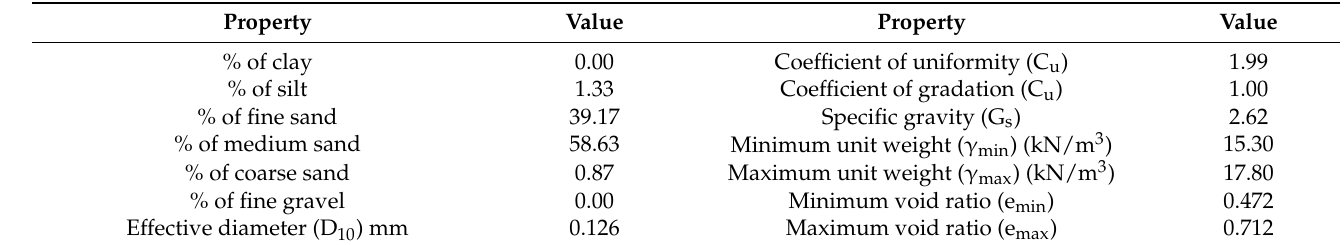
Table 1. Physical properties of soil.